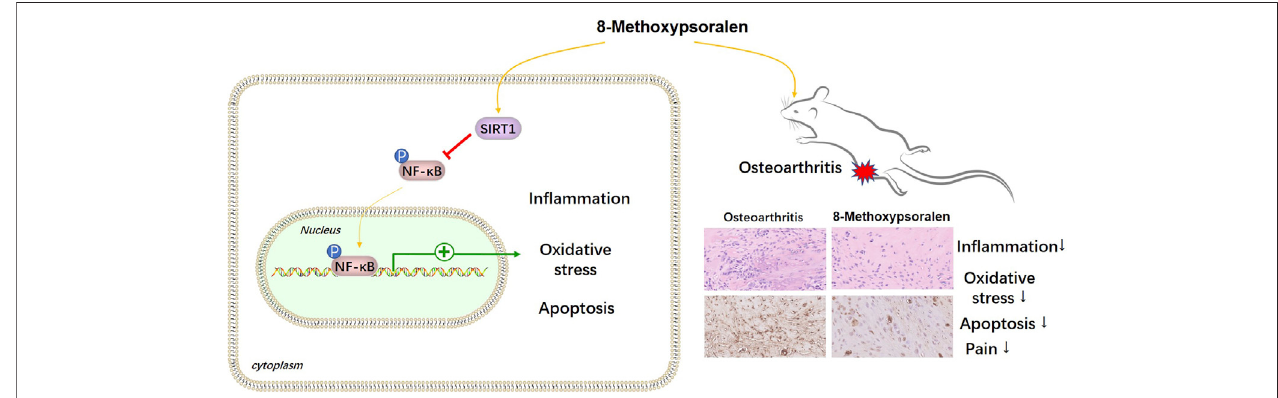
FIGURE 9 | The mechanism diagram. 8- MOP alleviates pain, in fl ammatory and oxidative stress responses in OA rats through the upregulation SIRT1 and inactivation of NF- κ B pathway.